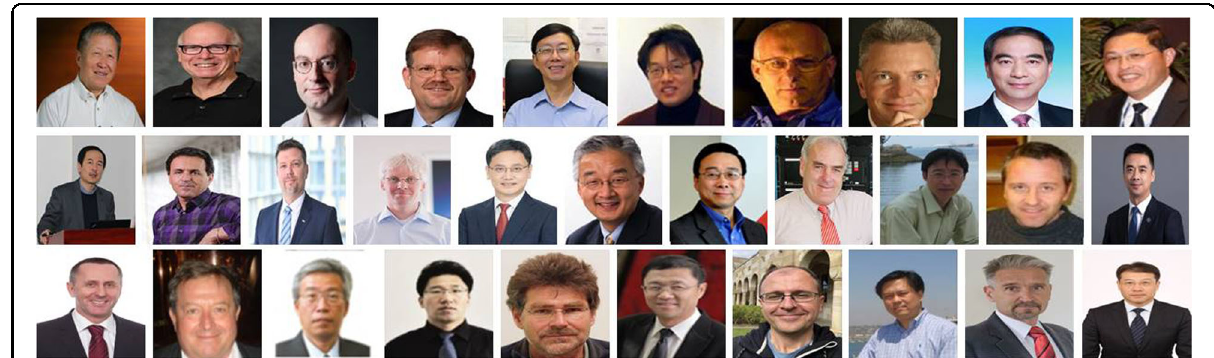
Fig. 2 Founding Editorial Board Members of Light: Science & Applications